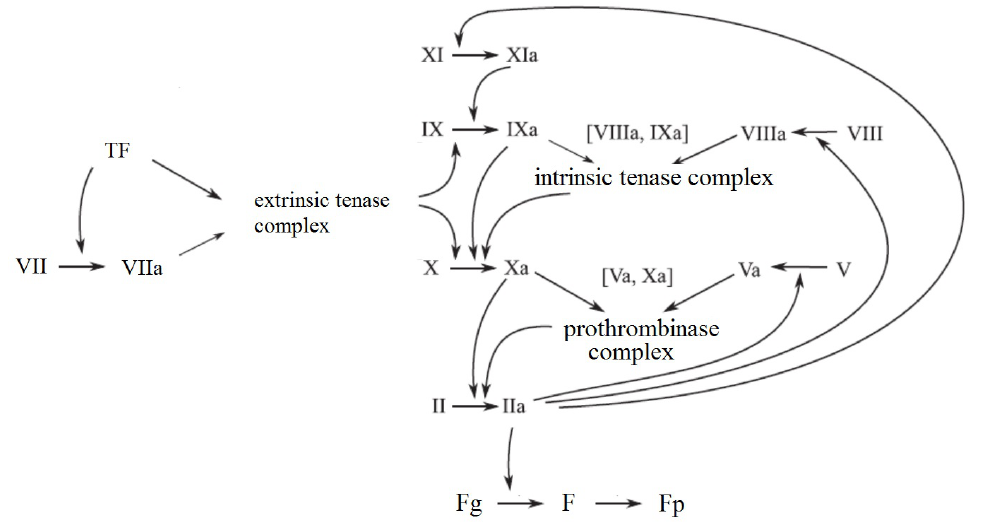
Figure 1. Schematic representation of the coagulation cascade in blood plasma. In the case of injury, the tissue factor initiates thrombin production. Thrombin is an enzyme that converts fibrinogen into fibrin, leading to the formation of fibrin clot. Thrombin (IIa) catalyzes the activation of factors V, VIII and XI; factors XIa and IXa catalyze the activation of factors IX and X, respectively; factors VIIIa and Va form active complexes with factors IXa and Xa, respectively, and further increase thrombin